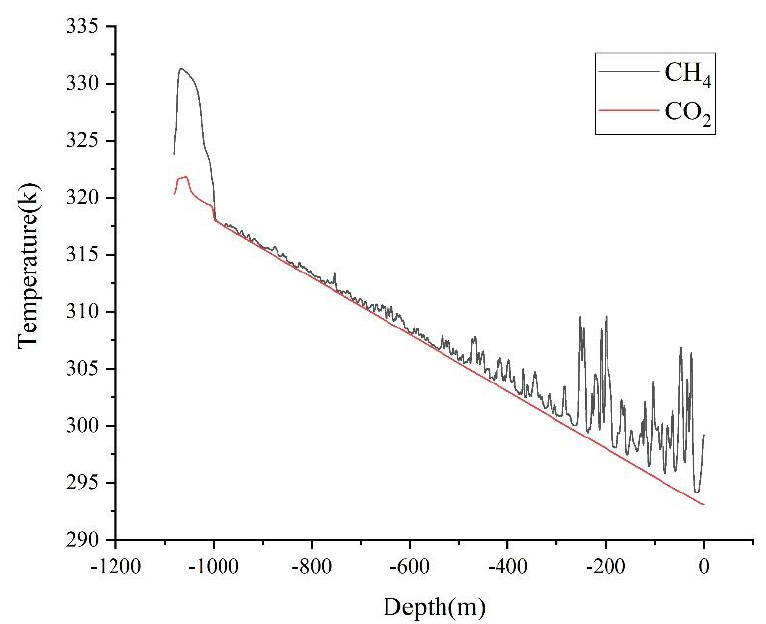
Figure 13. Temperature at cavity centerline at the end of withdrawal. Table 3. Inlet pressure over 10 days of constant gas withdrawal.